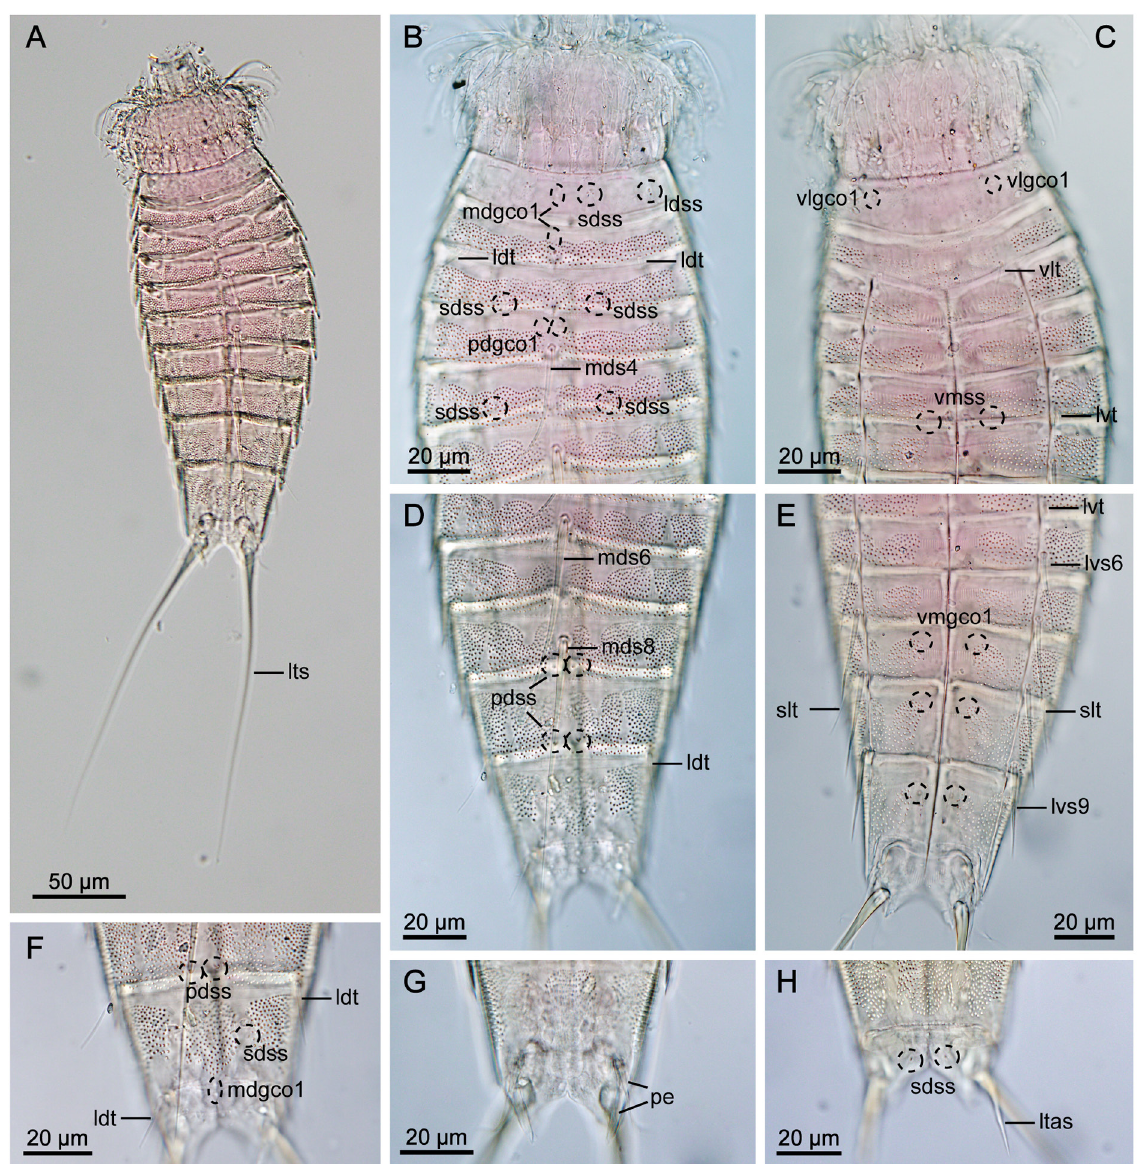
Fig. 12. Light micrographs showing overview and details of Echinoderes leduci sp. nov. A–G . ♂, holotype (NIWA-159405). H . ♀, paratype (NIWA-159406). A . Dorsal overview. B . Segments 1 to 6, dorsal view. C . Segments 1 to 6, ventral view. D . Segments 6 to 11, dorsal view. E . Segments 6 to 11, ventral view. F . Segments 9 to 11 of male, dorsal view. G . Segments 10 to 11 of male, dorsal view. H . Segments 10 to 11 of female, dorsal view. Abbreviations: see Material